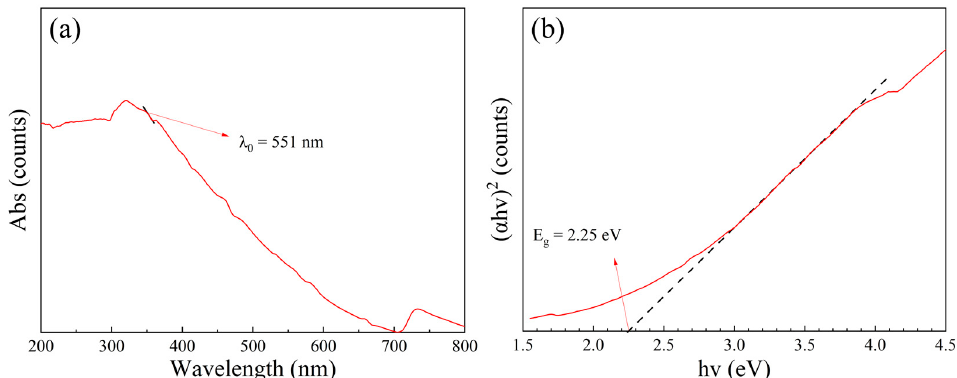
Figure 5. The UV-vis DRS spectrum of MM-CaTiO 3 . ( a ) The threshold wavelength analysis of MM-CaTiO 3 , and ( b ) the forbidden band gap analysis of MM-CaTiO 3 .